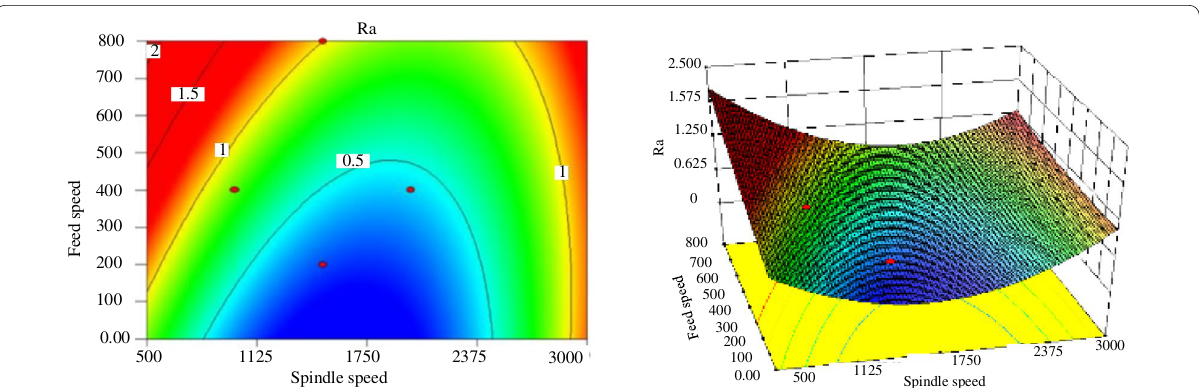
Figure 10 3D response surface figure of surface roughness regression equation [response surface and contour of ( A ) and ( B )]x